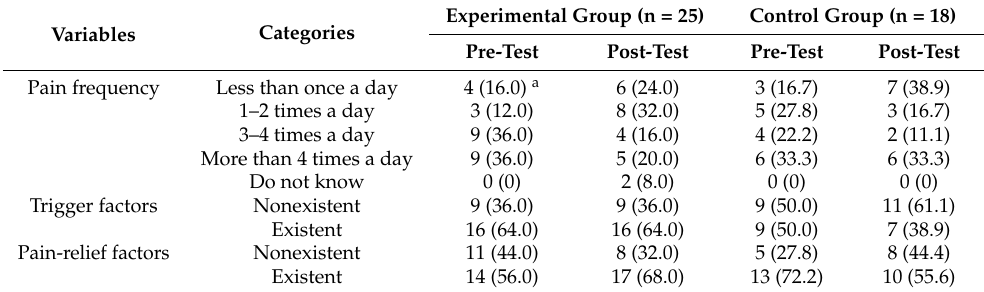
Table 3. Pain frequency, trigger factors, and pain-relief factors.